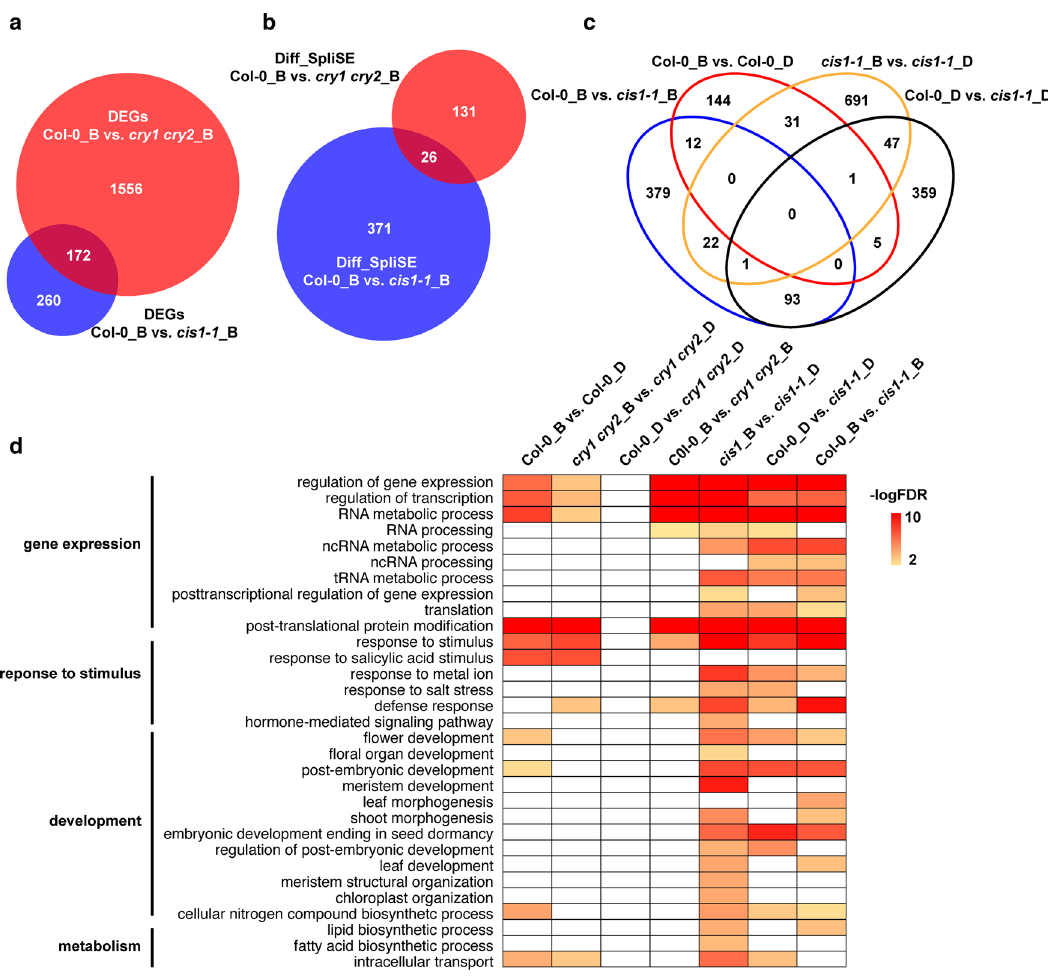
Fig. 3 |Bluelight and CRYsareinvolved in RNA splicing andsharetargetswith CIS1. a , b Venn diagram showing the overlap between sets of DEGs ( a ) and of differentiallysplice-sitestrengthestimategenes(DiffSpliSEin b )withFDR<0.01in Col-0versusthe cry1cry2 doublemutantinbluelight(Col-0Bvs. cry1cry2 B)orCol- 0versusthe cis1-1 mutantinbluelight(Col-0Bvs. cis1-1 B)at22°C. c Venndiagram showing the overlap between sets of differentially splice-site strength estimate